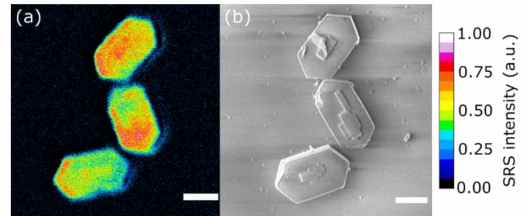
Figure 2. ( a ) SRS images at 1006 cm − 1 of chemisorbed pyridine in Zn000 crystals after desorption at 150 ◦ C under vacuum. The image was acquired in ambient conditions. ( b ) Scanning electron microscopy (SEM) image of the morphology of the crystals.